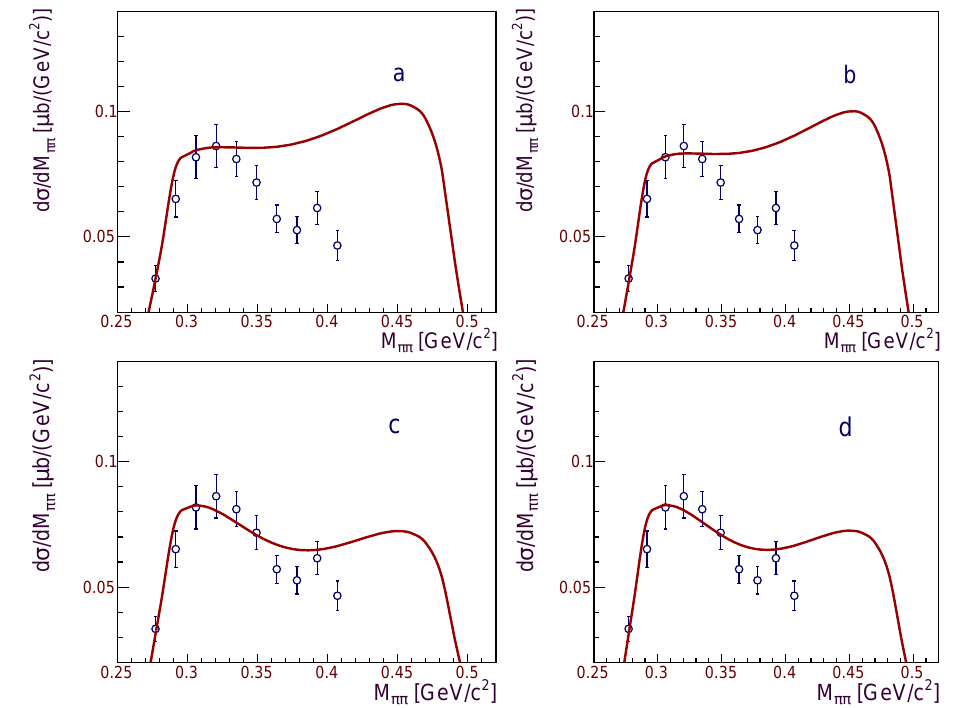
Figure 3: The distribution over the invariant mass of two final pions system M ππ at different orbital angular momenta. a : L = 2, l = 1, l = 3, d : L = 4, l c : L = 2, l 1 2 momenta in the vertices d + σ → D results of the model calculations (full lines) are normalized to the data [ 7 ] (open circles). In the calculations the scattering angle θ c . m . to the full interval 0 ◦ < θ c . m .